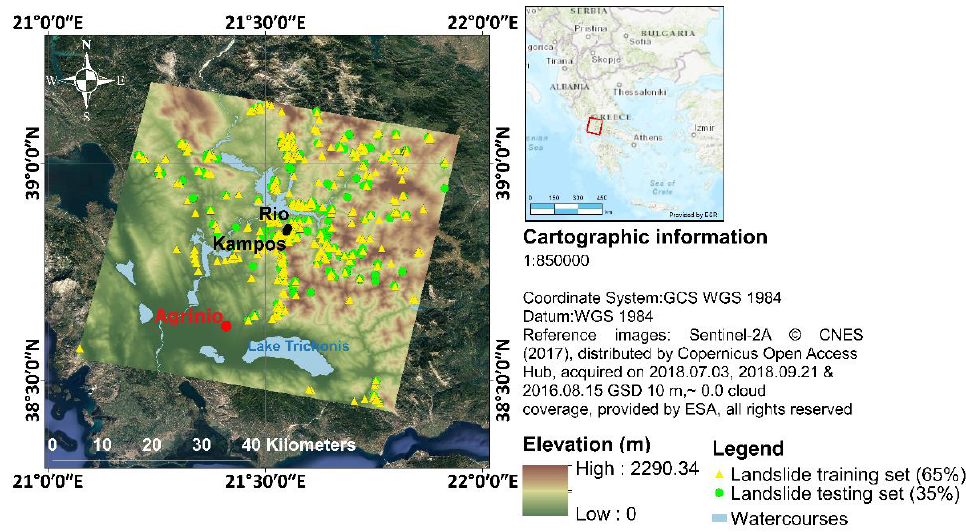
Figure 7. Landslide occurrences inventory divided into training and testing points.